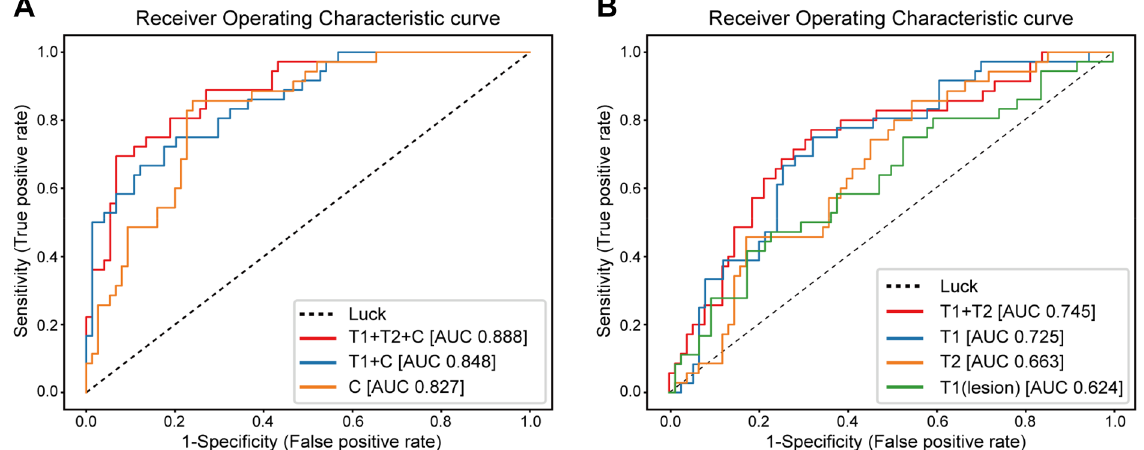
Figure 1. Receiver operating characteristic curves showing the AUC values of different deep learning models in the validation set. ( A ) ROC curves for the prediction of pretreatment pCR based on different deep learning models trained on clinical information and MR images or only clinical information pCR classifiers. T1 + T2 + C: subtracted-T1W images, T2W images, and clinical information. T1 + C: T1W subtraction images and clinical information. C: clinical information. ( B ) ROC curves for prediction of pretreatment pCR based on different deep learning models trained on the dataset in the combinations of MR images. T1 + T2: T1W subtraction images and T2W images. T1: T1W subtraction images. T2: T2W images. T1 (lesion): cropped image of the lesion in T1W subtraction